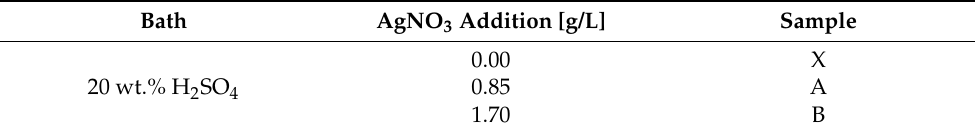
Table 1. Samples labelling, with relative anodization bath